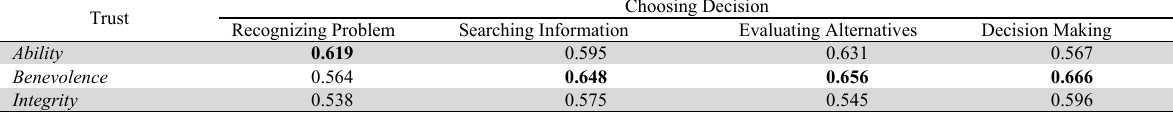
Choosing Decision